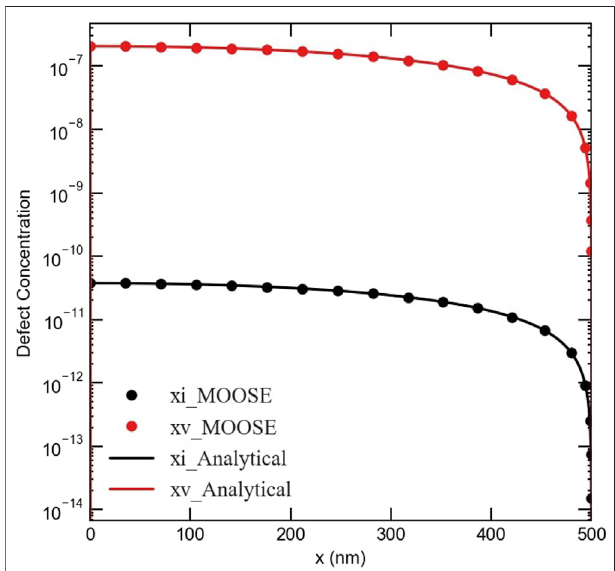
FIGURE 1 | A comparison between MOOSE results and the analytical solutions for the fractions of point defects in an irradiated spherical Ni grain with a 500 nm radius. The grain boundary/surface at x (cid:1) 500 nm is assumed perfect and